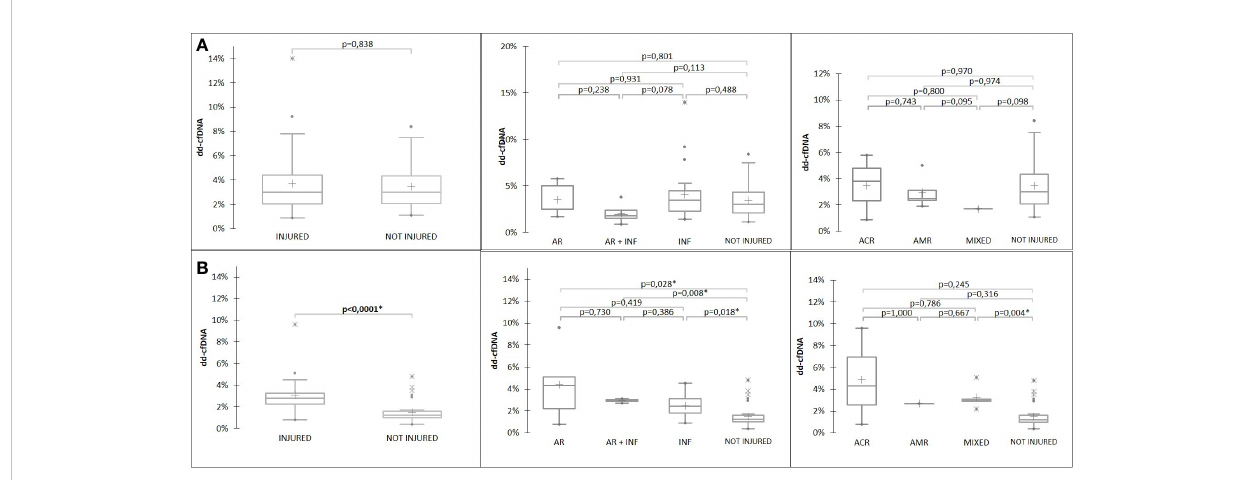
FIGURE 3 %dd-cfDNA at D15 (A) and at D30 (B) according to patient